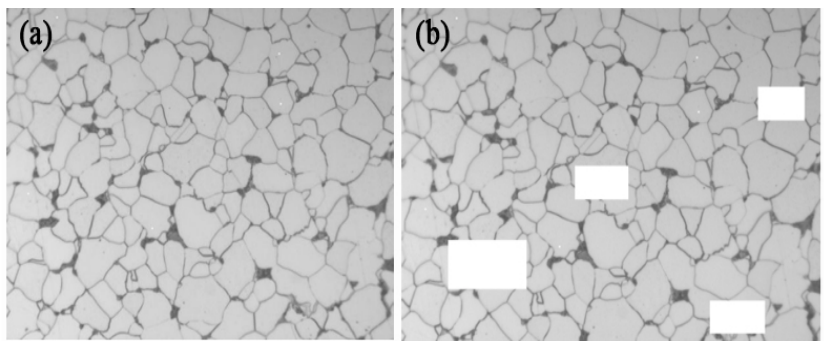
Figure 5. Random erasing images (Original ( a ), Erased ( b )).